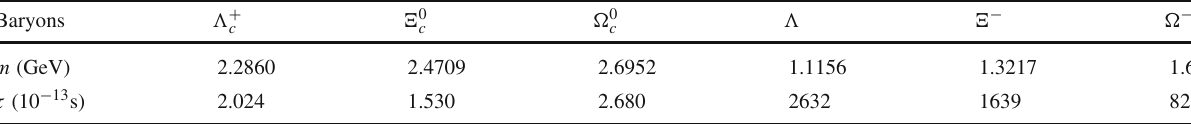
Table 1 The masses ( m ) and lifetimes ( τ ) of baryons [29] Baryons